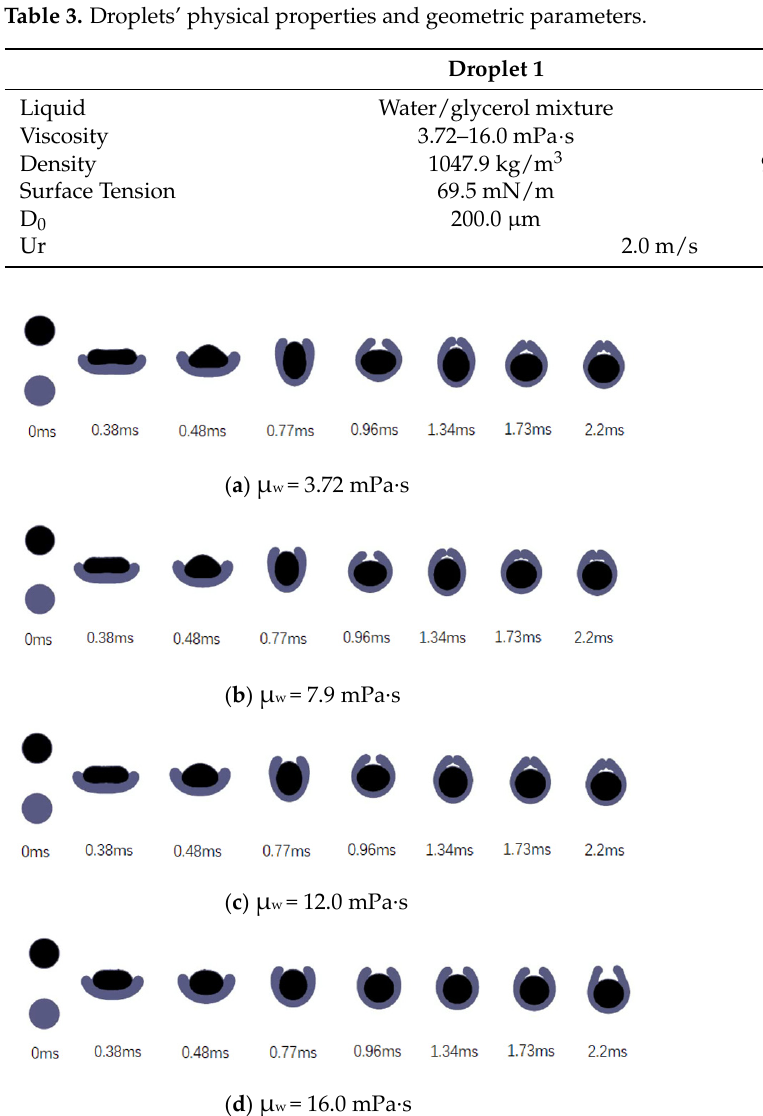
Figure 6. Simulated images of the collision process between a water/glycerol droplet and a silicone oil droplet ( We = 11.9) at different viscosities of the aqueous phase: ( a ) 3.72 mPa·s; ( b ) 7.9 mPa·s; ( c ) 12.0 mPa·s; ( d ) 16.0 mPa·s.